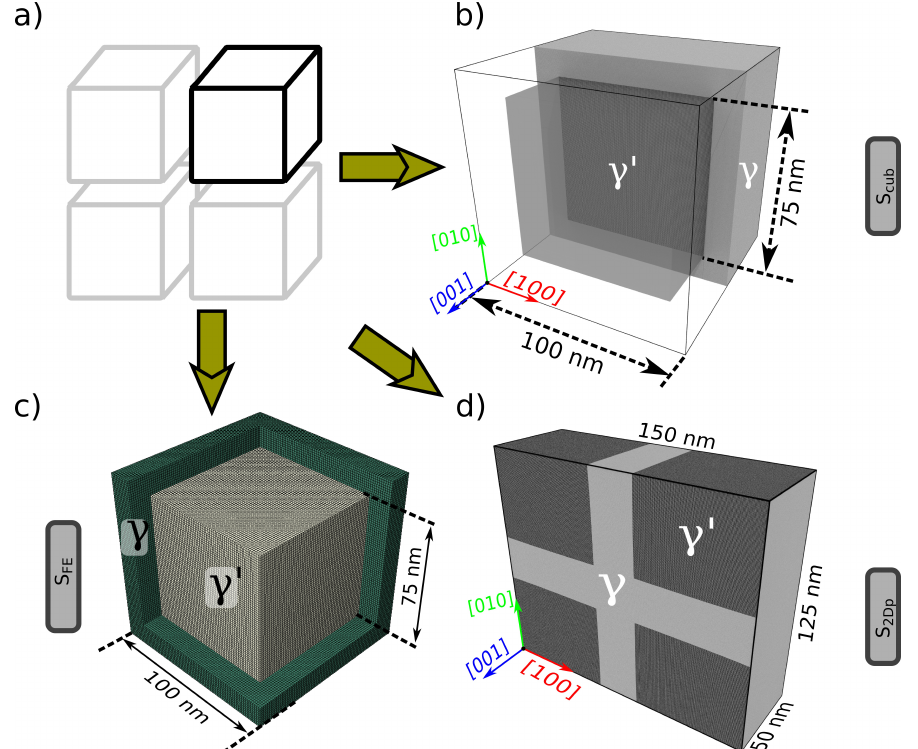
Figure 1. Simulation setup of the idealized samples used in the current work. ( a ) Schematic picture of the idealized γ / γ (cid:48) microstructure showing cube-shaped γ (cid:48) particles embedded in a matrix; ( b ) Atomistic model of the idealized γ / γ (cid:48) microstructure. Due to symmetry, only one cube-shaped γ (cid:48) particle, highlighted in black in (a), of a length of 75 nm embedded in a matrix of a width of 25 nm, is used in the simulations. The atomistic sample contains approximately 90 million atoms. periodic boundary conditions (PBCs) are imposed in all directions. The γ (cid:48) particle is shown as a transparent surface for visualization purposes; ( c ) Meshed structure for FE simulations. The dimensions correspond to that of the atomistic structure in (a). PBCs are imposed in all directions using external control nodes. The elements in γ (cid:48) are colored grey, whilst those in γ are colored green; ( d ) Quasi-2D simulation sample with planar interfaces. This setup corresponds to a planar cut of the idealized γ / γ (cid:48) microstructure and extrusion along the thickness direction so as to obtain two orthogonal and two parallel channels. PBCs are imposed only along the thickness ( z || [ 001 ] ) direction. Color code (for the atomistic simulation samples): Ni atoms are colored grey, whilst the Al atoms are colored